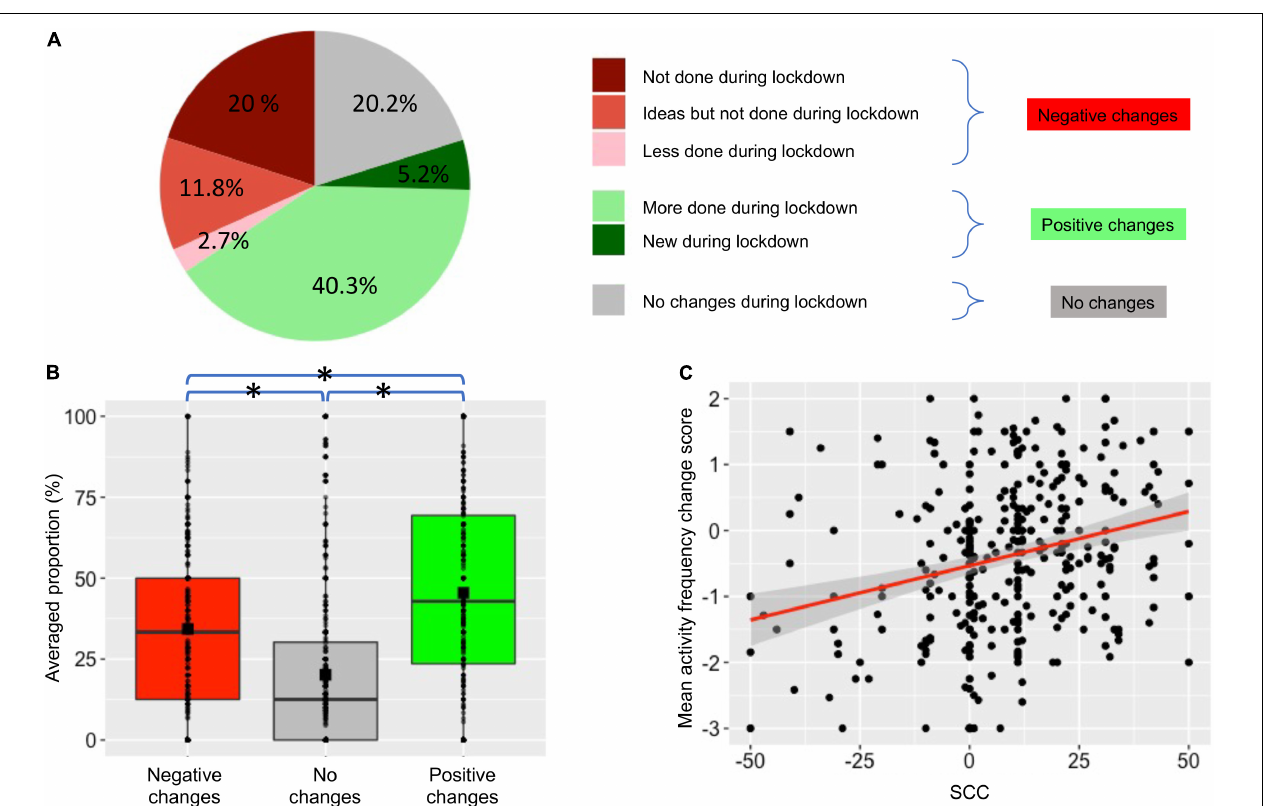
FIGURE 3 | Quantitative changes in performing creative activities during the lockdown period. (A) Averaged proportions of changes across participants in performing activities. We show the activities with negative changes, positive changes, and no changes separately. The activities with negative changes were not done during the lockdown (dark red), were not done, but participants had ideas to do it (light red) or were done less frequently than before the lockdown (pink). The activities with positive changes were done more frequently (light green) or were new (dark green) during the lockdown. The activities with no changes were done as frequently (gray) as before the lockdown. (B) Averaged proportion of changes across participants for negative changes (red), no changes (gray), and positive changes (green) during the lockdown period compared to the five last years. Each dot represents a participant, color boxes represent the upper and lower quartiles, and squares indicate the mean. Stars indicate post-hoc tests with a p corr < 0.05. (C) Participant’s SCC as a function of the averaged activity frequency change score (a dot per participant). The red line indicates a significant correlation between SCC and the mean activity frequency change score (Spearman correlation, p < 0.05).